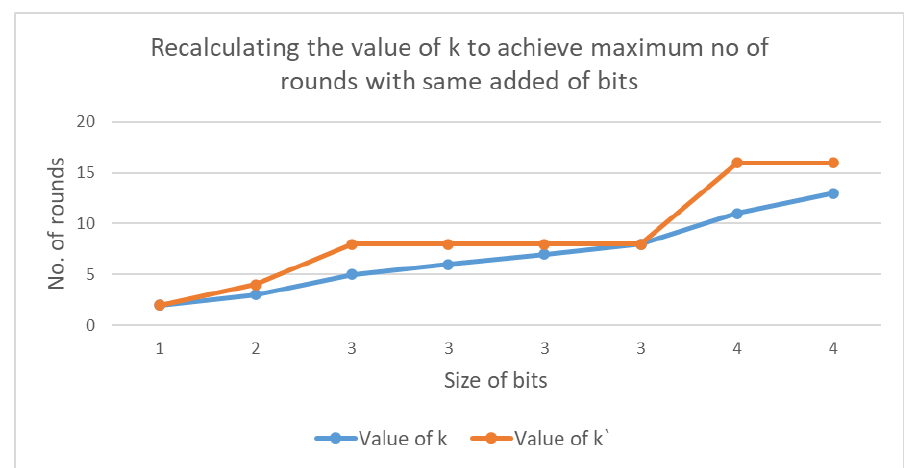
Figure 32. Recalculating k (cid:48) to increase the maximum number of rounds to the size of added